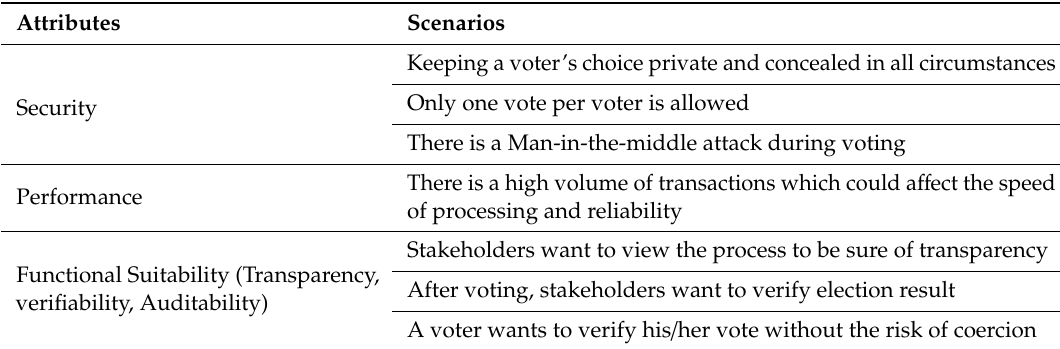
Table 3. ATAM attributes and scenarios (Thebus and Daramola,